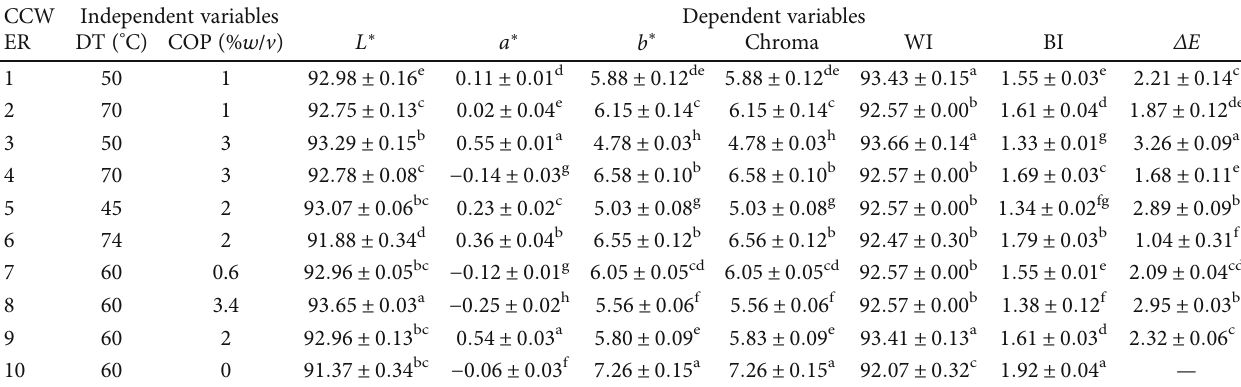
Table 5: Experimental runs and colour properties of cassava fl our (CCW) under di ff erent processing conditions. CCW Independent variables Dependent